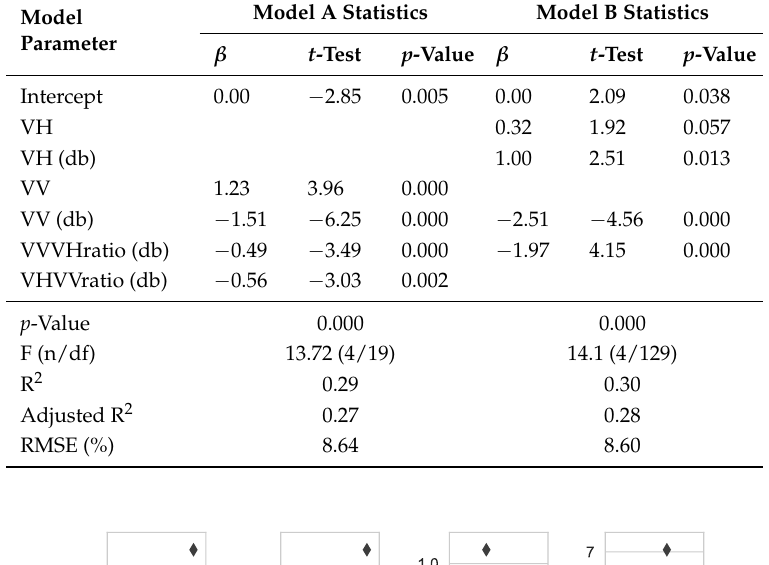
Table 4. Summary statistics for the stepwise regression models of canopy gap fraction.